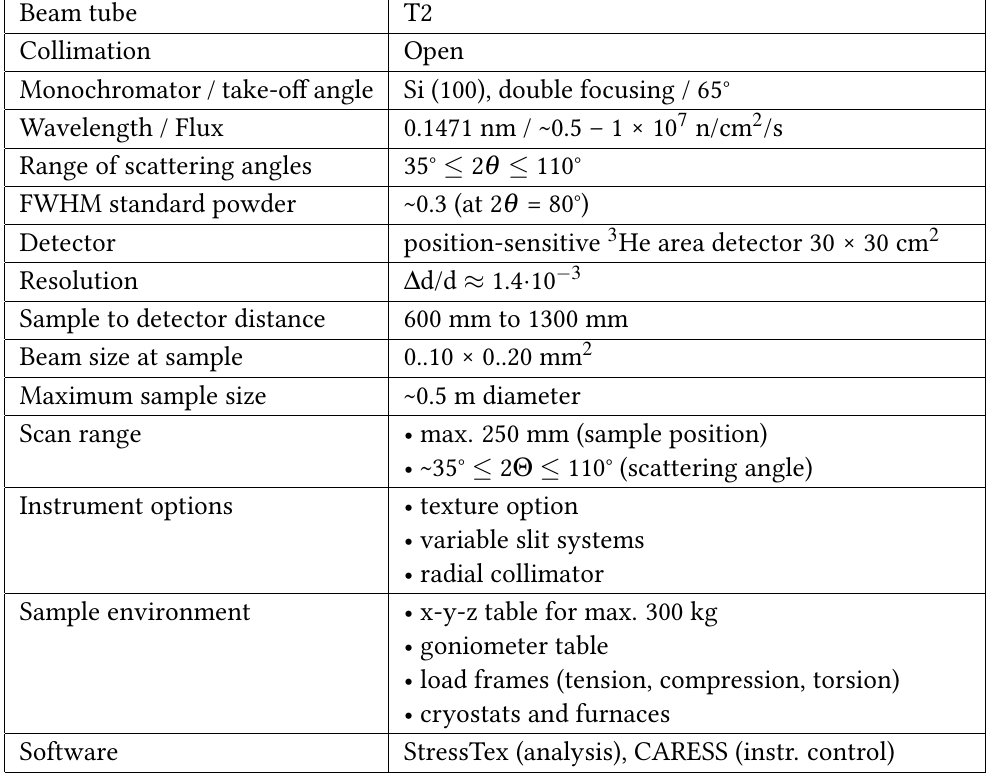
Table 1: Technical data of